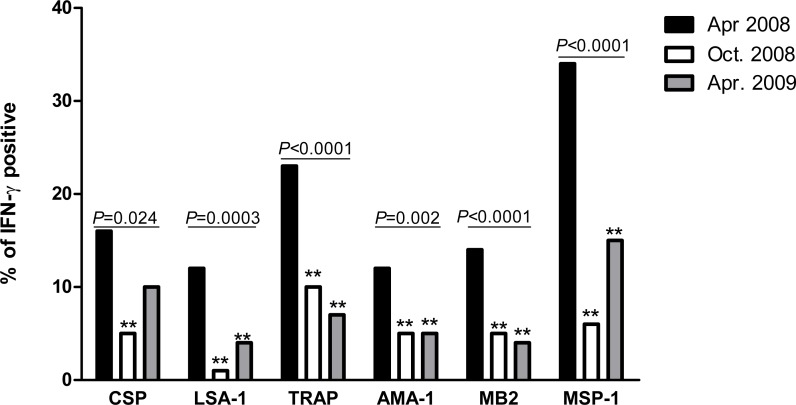
Proportion of individuals with positive IFN-γ responses to P. falciparum antigens in April 2008, October 2008 and April 2009.The prevalence of antigen-specific responses across time was assessed by the chi-square test for trend. The P values are indicated across the bars. Bars marked with double asterisks (**) differ significantly (P < 0.05) from baseline (April 2008).